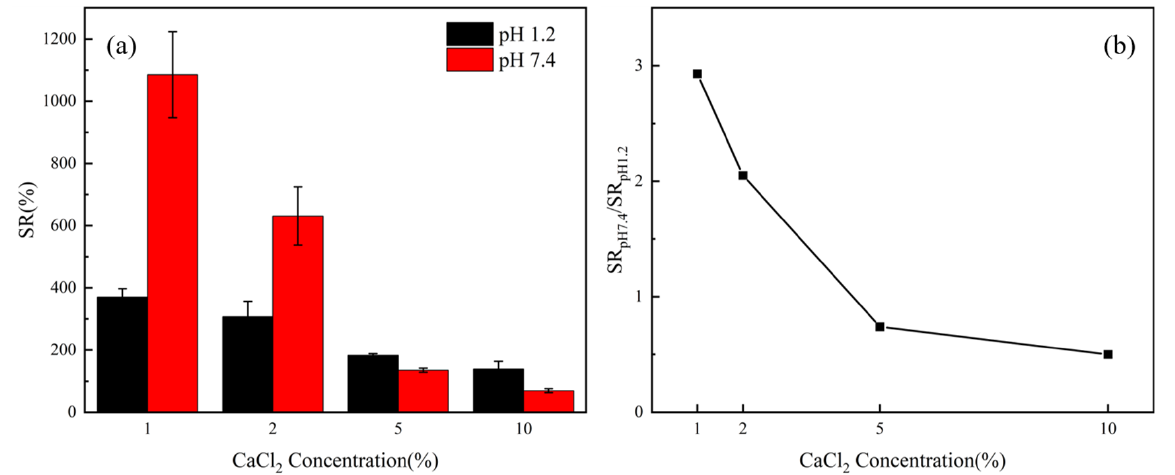
Figure 2. Effect of calcium ion concentration on pH-responsive properties of hydrogels. ( a ) Swelling rate of hydrogels crosslinked with CaCl 2 at various concentrations for pH 1.2 and pH 7.4. ( b ) Ratio of the swelling rate of hydrogels at pH 1.2 and 7.4 as a function of calcium ion concentration.